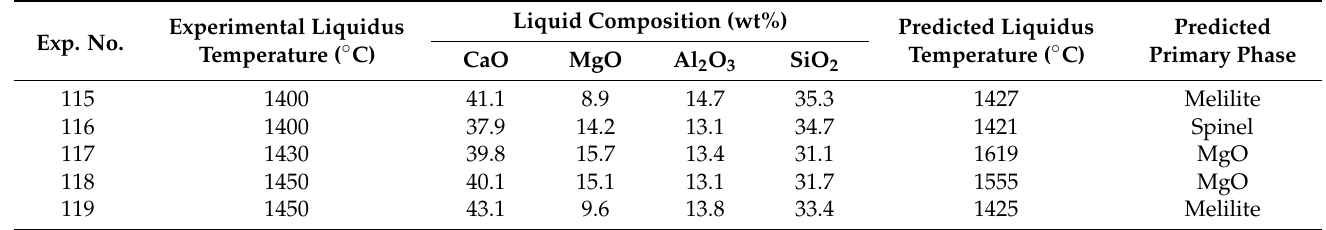
Table 3. Comparison of the experimental data with the FactSage prediction on primary phase and liquidus temperature; merwinite is the primary phase in all